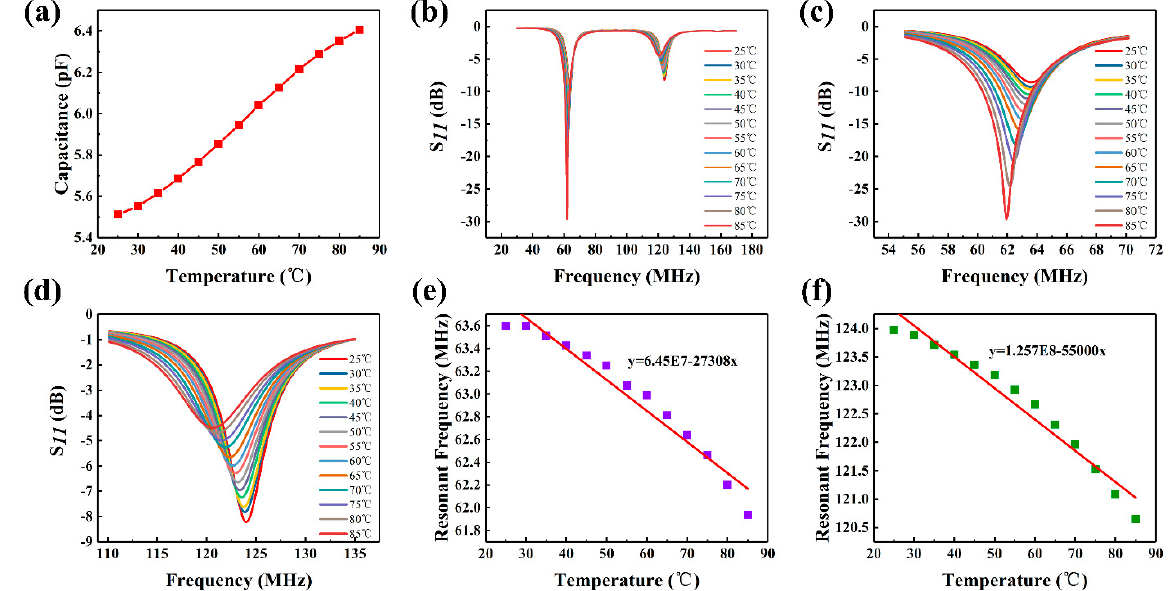
Figure 5. Temperature results of the dual-parameter wireless sensor: ( a ) Plate capacitance change as a function of temperature; ( b ) Temperature response curve (25–85 °C) of the dual-parameter sensor, and an ( c ) enlarged view of the temperature response curve of the temperature-sensitive unit. ( d ) Enlarged view of the temperature response curve of the strain-sensitive unit; ( e ) fitted curve of the temperature response curve of the temperature-sensitive unit, and ( f ) Fitted curve of the temperature response of the strain-sensitive unit.